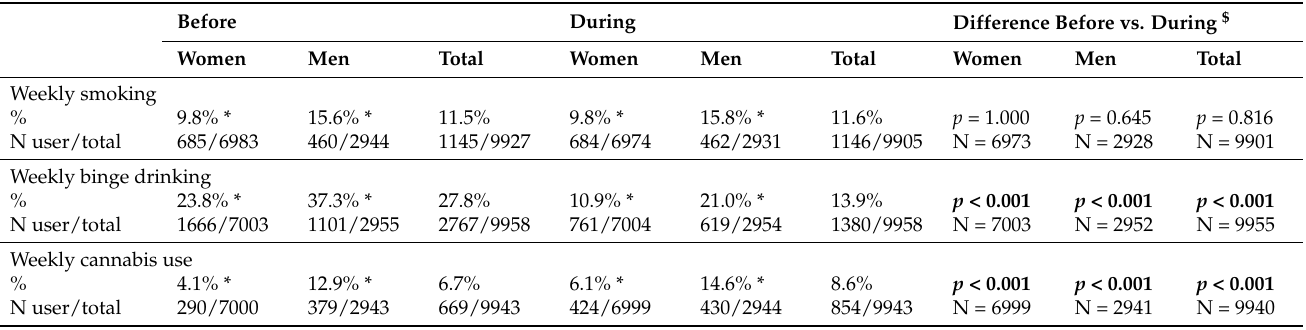
Table 2. Prevalence of weekly smoking, weekly binge drinking and weekly cannabis use both